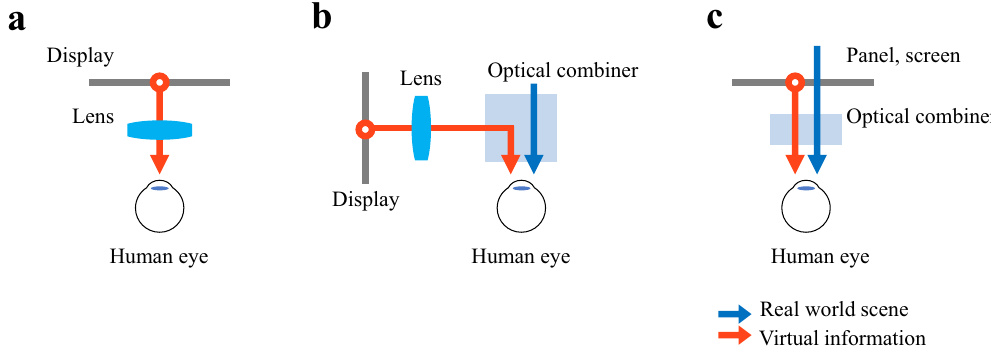
Figure 1. Basic configurations of various HMDs: ( a ) VR-HMD, ( b ) conventional AR-HMD, and ( c ) AR-HMD with